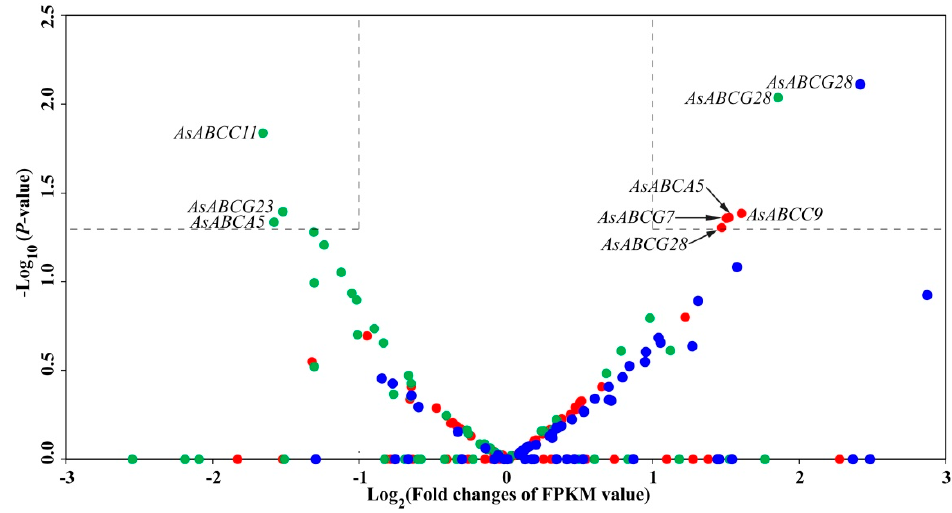
Figure 4. Expression profile of ABC transporter genes in three pyrethroid-resistent field populations (AH-FR, CQ-FR, and YN-FR) compared with a laboratory-susceptible strain (WX-LS), detected by RNA-seq. Genes with FPKM value ≥ 2 (i.e., ≥ 1 in Log 2 , showing on X -axis) and p -value < 0.05 (i.e., > 1.30 in –Log 10 , showing on Y -axis) are considered to be significantly upregulated, whereas those with FPKM value ≤ 0.5 ( ≤ − 1 in Log 2 ) and p -value < 0.05 are regarded as downregulated. Vertical dotted lines mark the 1 and − 1 of Log 2 (fold changes of FPKM value) values on the X -axis, and horizontal dotted lines denote the p -value = 0.05 of –Log 10 ( p -value) on the Y -axis. There are six genes that are significantly differently expressed in different populations, in which four genes are upregulated ( AsABCG28 commonly in three populations) and three genes are downregulated (AsABCA5 is upregulated in AH-FR but downregulated in CQ-FR). The red-, green-, and blue-filled circles indicate the AH-FR, CQ-FR, and YN-FR, respectively.